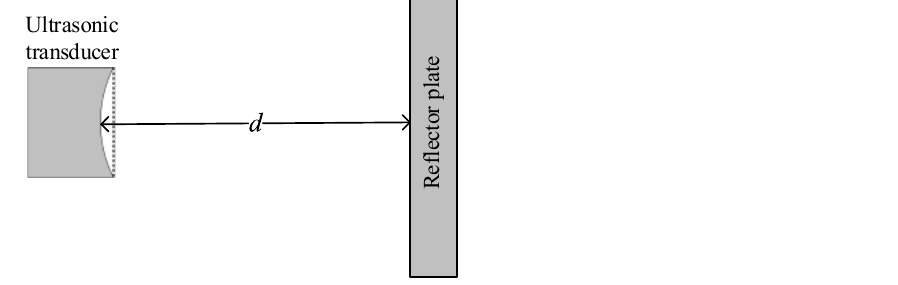
Figure 6. Diagram of distance d between the radiating surface of the ultrasonic transducer and the reflector plate.